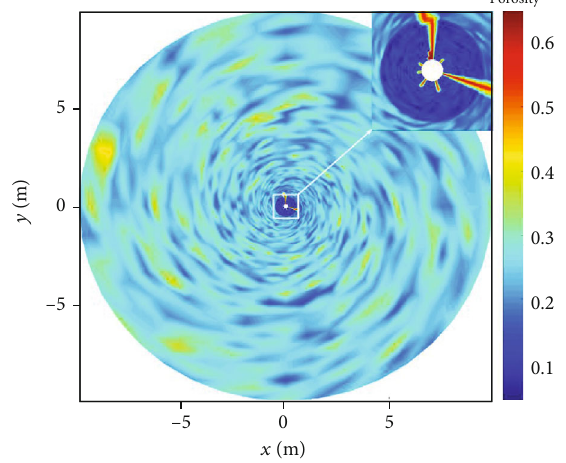
Figure 11: Porosity distribution near the injection well after enhancing the injection